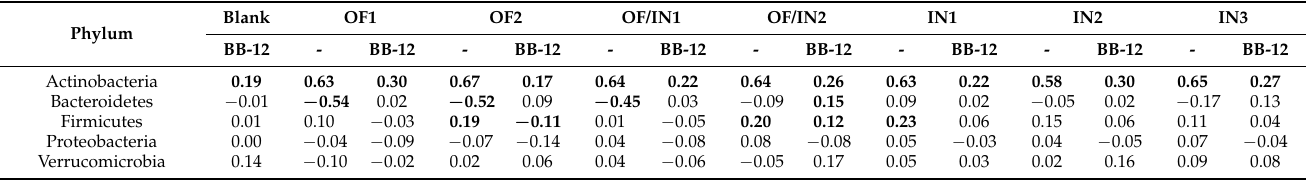
Table 3. Changes of microbial abundances at phylum level (log(cells/mL)) as detected via quantitative 16S-targeted Illumina sequencing at the end of the colonic incubation (48 h) upon dosing BB-12 and/or seven fructans with short (OF1, OF2), intermediate (OF/IN1, OF/IN2) and high degree of polymerization (IN1, IN2 and IN3) to the complex microbiota of three human donors (C, D and F). The values represent average differences versus the respective reference (for fructans, the reference was the untreated blank, while for conditions with BB-12 addition this was the respective condition where BB-12 was not dosed) at the end of the colonic incubation over the three donors. Significant changes are indicated in bold ( n = 9; 3 values for each of the 3